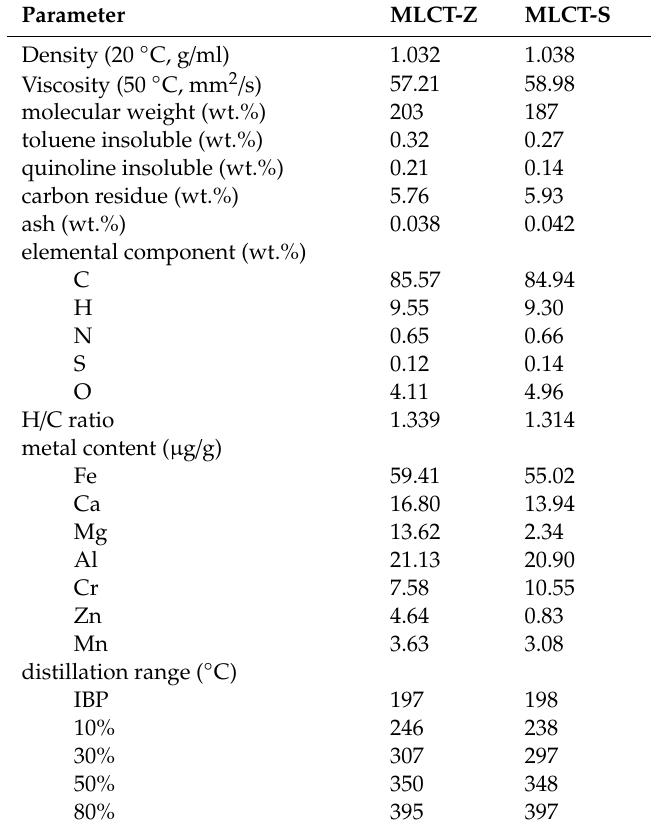
Table 1. The typical properties of medium-low temperature coal tar